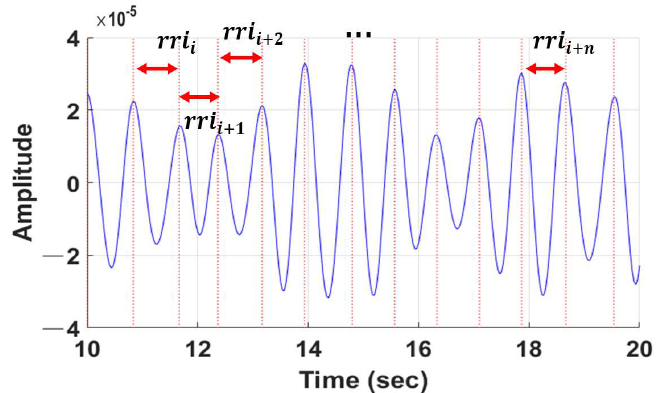
Figure 11. RR interval calculation of the pulse wave.